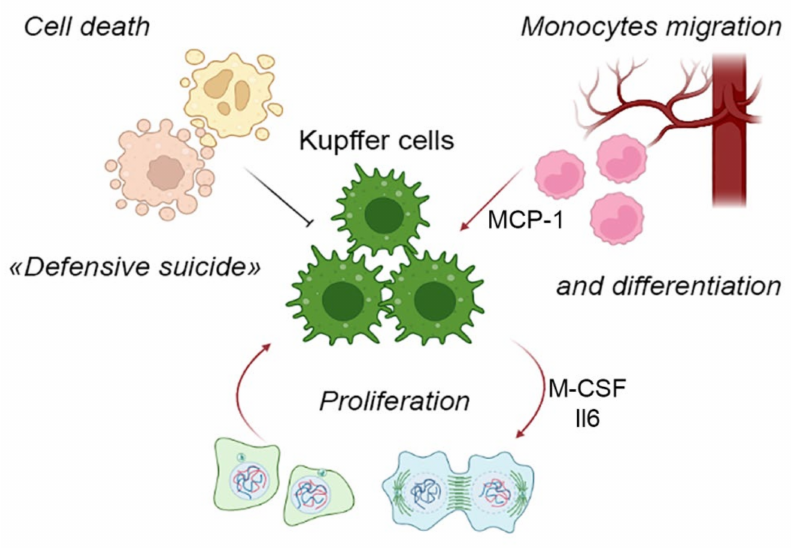
Figure 1. Component processes of the liver macrophage population